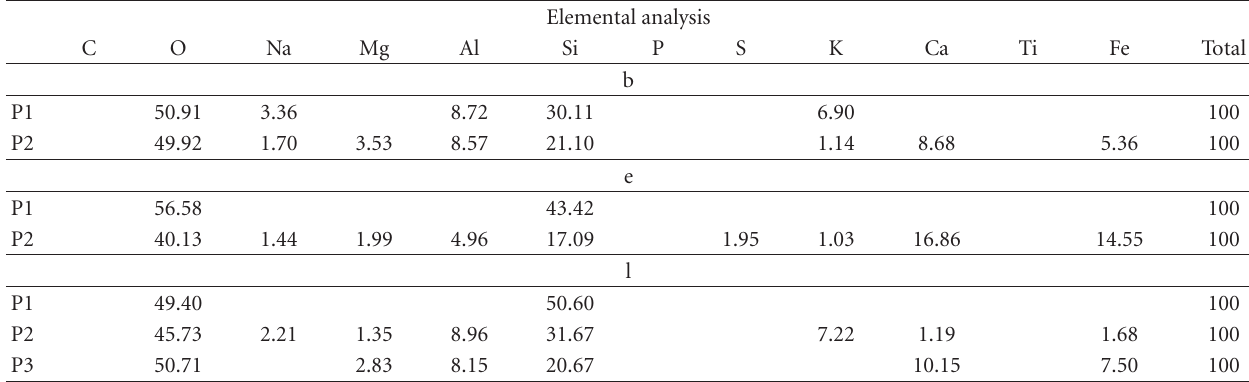
Table 7: SEM-EDS elemental analyses of briquettes (wt%). Elemental